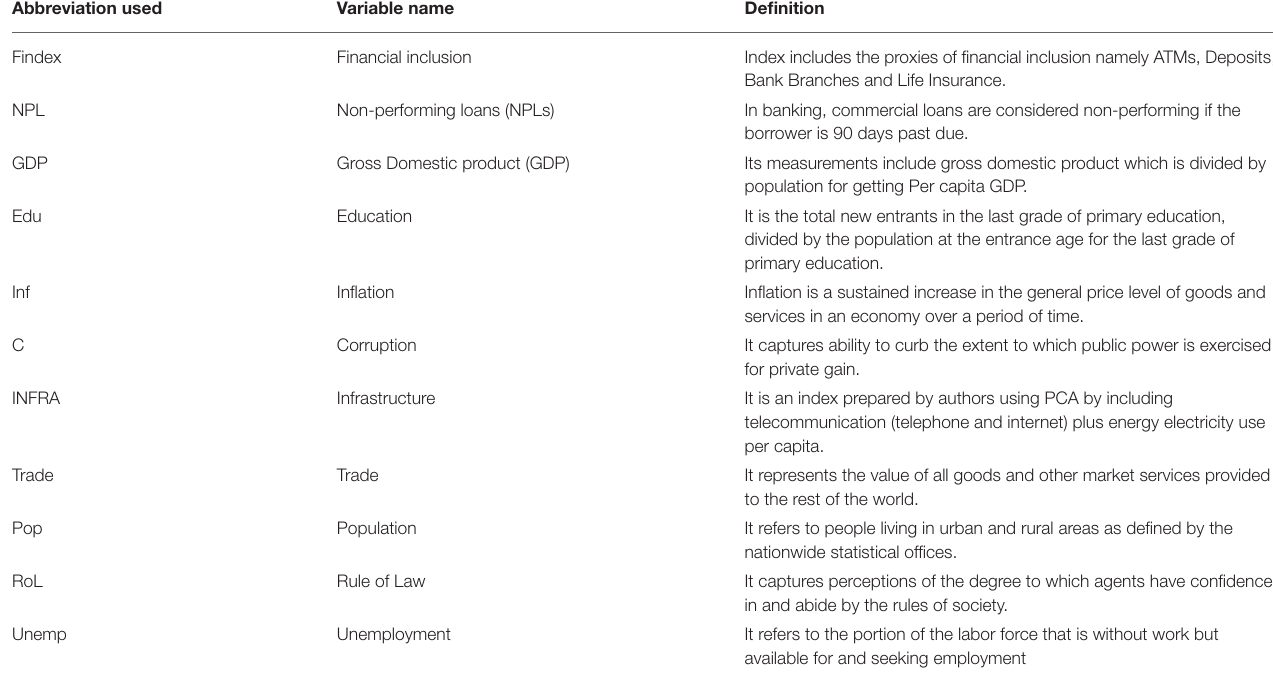
TABLE 1 | Definitions of study